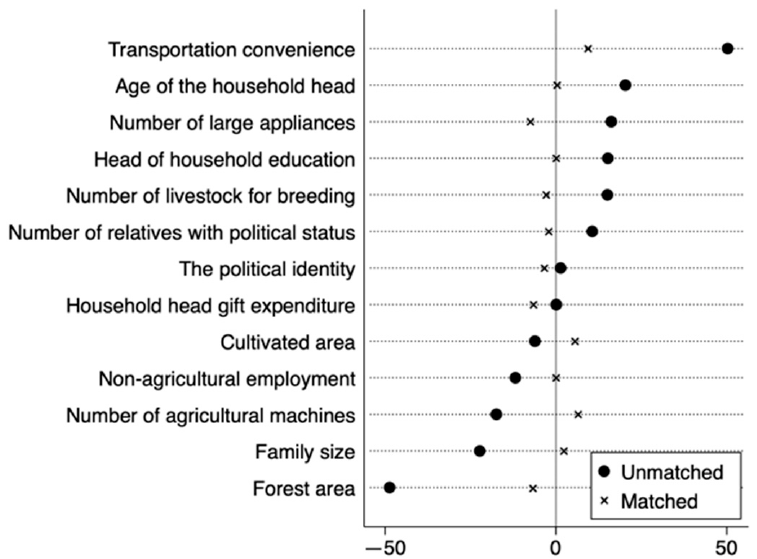
Figure 4. The deviation distribution of the sample covariates.